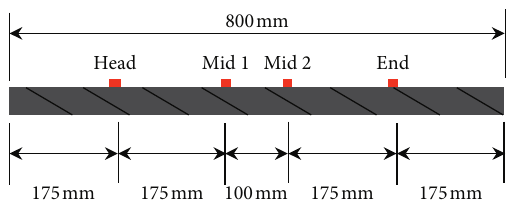
Figure 7: Installation of strain gauge.